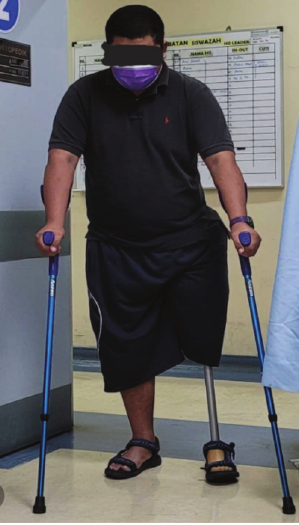
Our patient at his 18-month follow-up in the clinic Fig. 2: (mobilising with